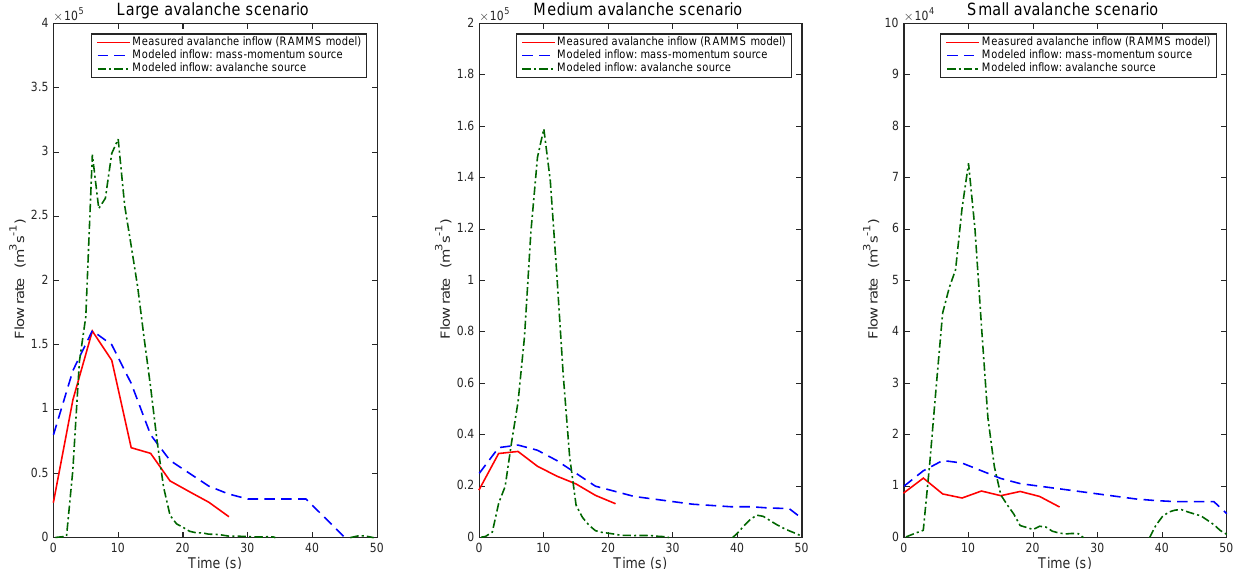
Figure 5. Inflow hydrographs for the avalanche as it enters the lake for the avalanche source and mass–momentum source boundary conditions as compared to the hydrograph extracted from the RAMMS avalanche model.